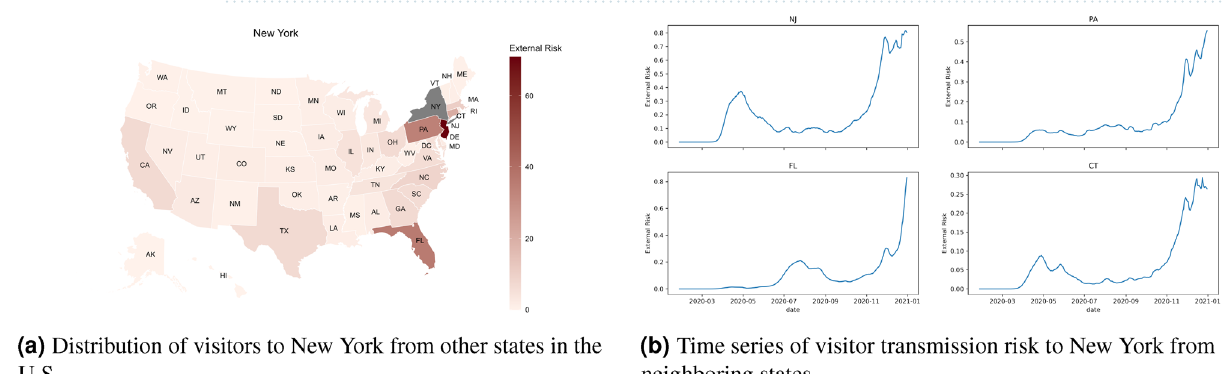
Figure 3. Visitor transmission risk and mobility patterns to the state of Louisiana from other states in the United States. Map generated using urbnmapr 33